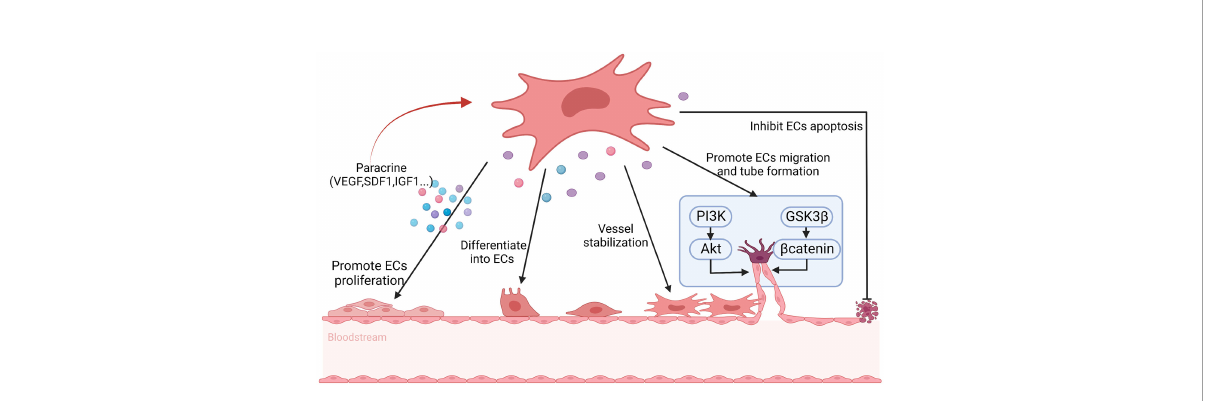
FIGURE 4 The possible mechanisms of BMSCs promote angiogenesis in POF. BMSCs help to promote angiogenesis through differentiating into endothelial cells (ECs), maintaining vascular stability, inhibiting ECs apoptosis and secreting angiogenic factors, including vascular endothelial growth factor (VEGF), stromal cell derived factor 1 (SDF1) and insulin-like growth factor 1 (IGF1) et. to promote ECs proliferation, as well as promoting ECs migration and tube formation via PI3K/Akt and GSK3 b / b catenin signal pathway. At the same time, the secrete factors reinforce the angiogenesis of BMSCs in